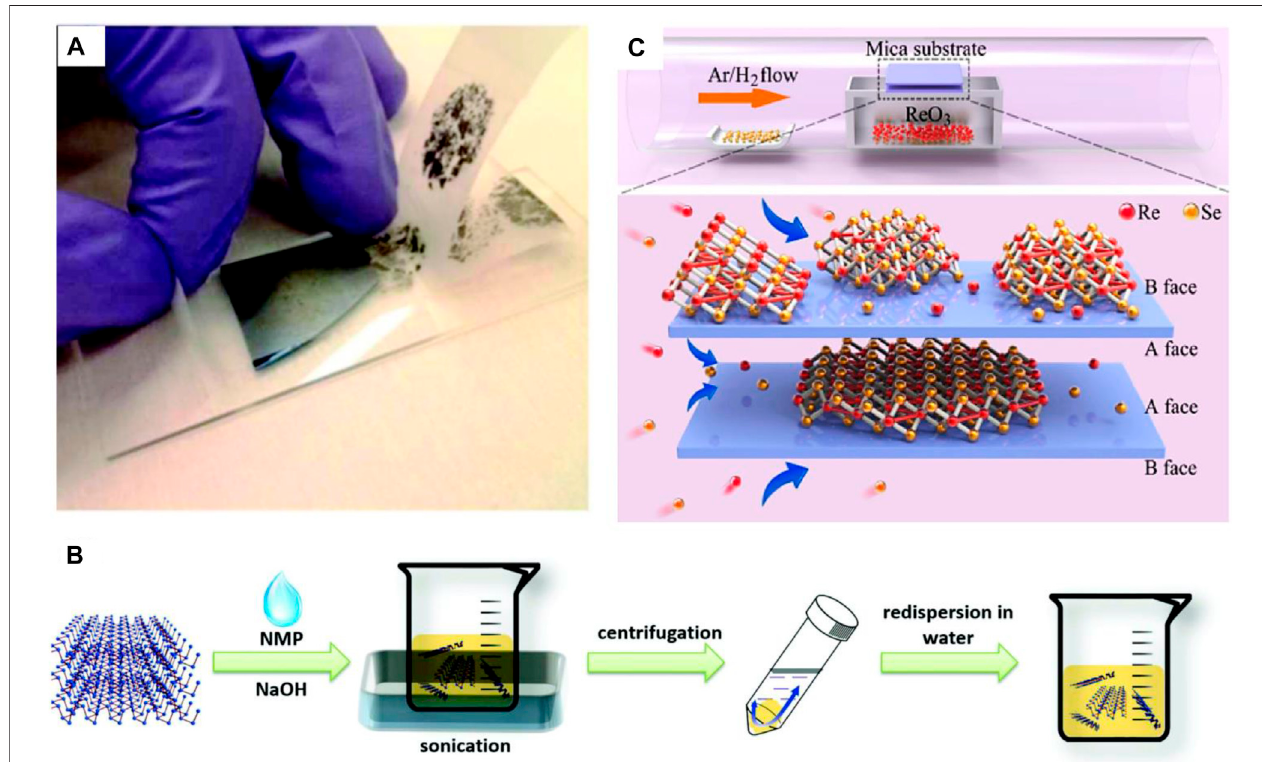
FIGURE 6 | Schematic of 2D material synthesis methodologies (A) Mechanical exfoliation technique (Huang et al., 2015), (B) Liquid phase exfoliation (Guo et al., 2015), and (C) Chemical vapor deposition (Cui et al., 2017); Reproduced with permission from (Guo et al., 2015; Huang et al., 2015; Cui et al., 2017).